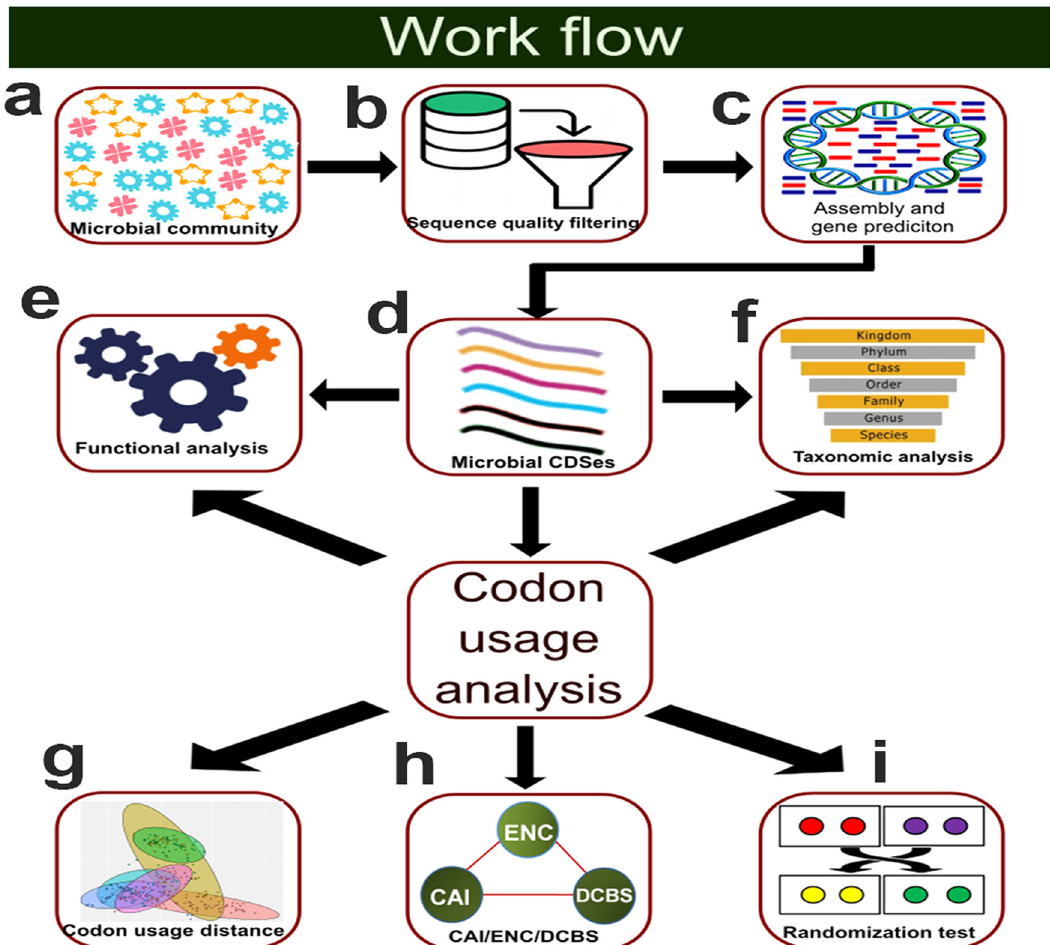
Fig. 1 Metagenomic work fl ow. Here we described the steps that were employed in this analysis. a At the fi rst step, raw metagenomic reads of each sample were collected from the Sequence Read Archive (SRA) database. b Reads were processed with a rigorous metagenomic pipeline and assembled. c , d From the assembled contigs, we predicted CDS (and protein) sequences that were employed for the codon usage analysis. e , f To understand how taxonomic and functional diversity in fl uence the codon usage of the samples, we annotated the samples with the functional and taxonomic information and analyzed their impacts in detail. g . Analysis of codon usage similarity among different environmental samples. h To understand the codon usage speci fi city of the samples we calculated three indices of codon usage namely ENC, CAI, and DCBS values. i Next, we tested whether there is any evidence of selection on the codon usage of the samples by comparing the CAI/ENC/DCBS values of real sequences of the samples with their corresponding random